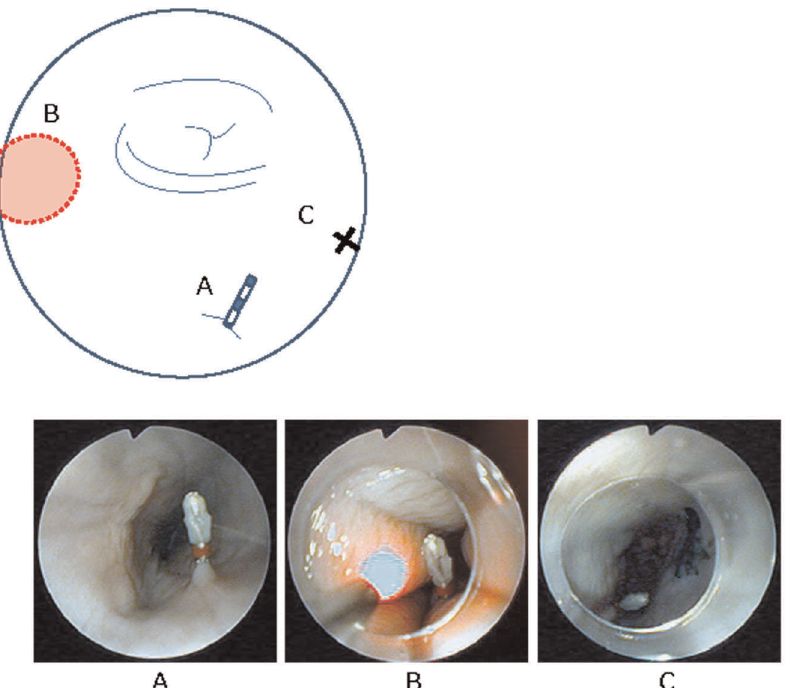
Figure 5. Standard operation procedure for laser irradiation. The site of laser irradiation was fixed at 9 o’clock (A) in all animals because this direction was easiest for holding an endoscope stably and irradiating with a laser. Before laser irradiation, the site at 5 o’clock (B) was marked in advance with a clip. After completion of the laser irradiation (C), the site at 3 o’clock (D) was tattooed to identify the irradiation site for follow-up and